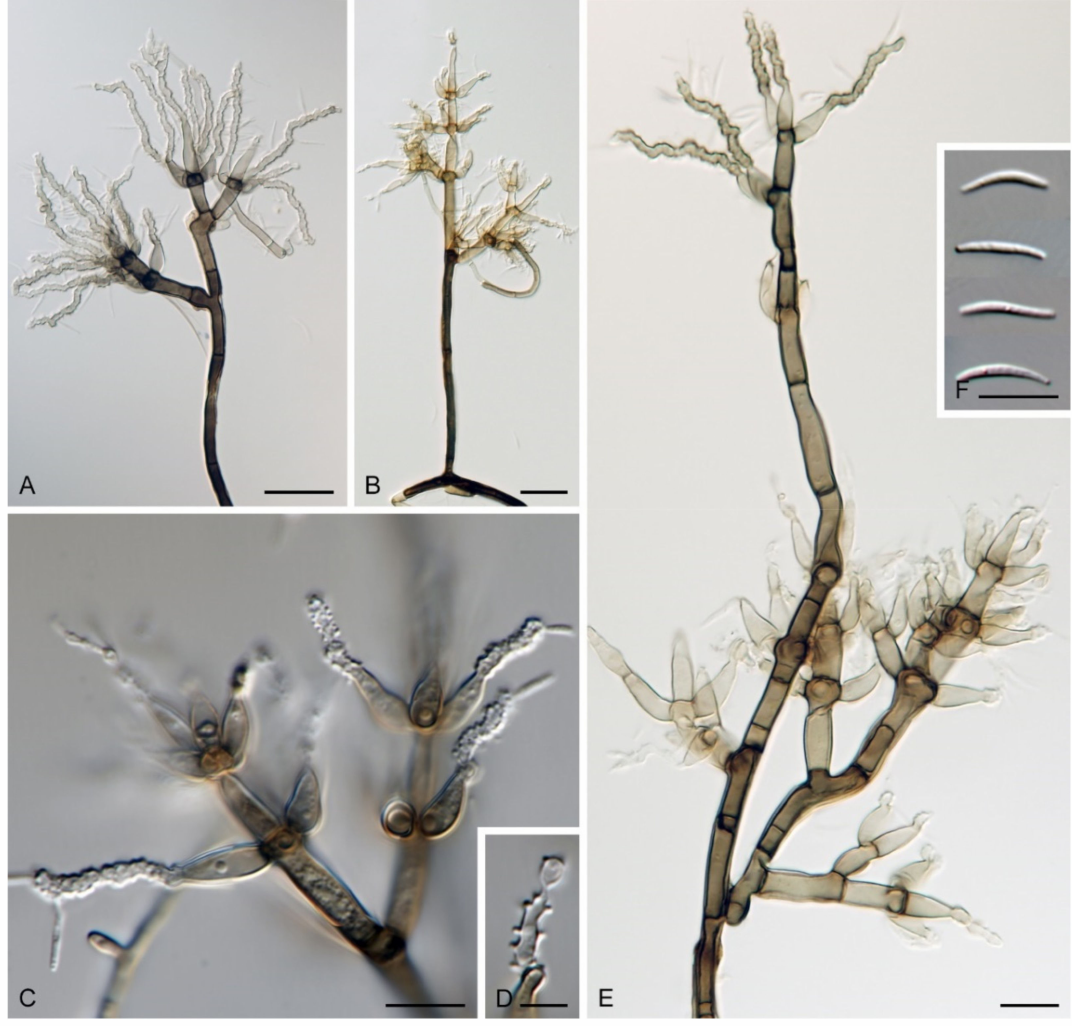
Figure 21. Selenosporella curvispora (CBS 102623). ( A , B , E ) Conidiophores. ( C , D ) Conidiogenous cell, in detail. ( E ) Conidia. Images: ( A – E ) on CMA after 8 weeks. Bars: ( A B ) = 20 µ m; ( C , E , F ) = 10 µ m; ( D ) = 5 µ